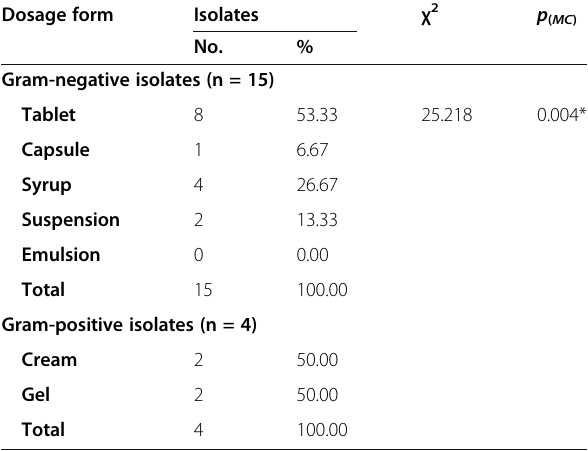
Table 4 Distribution of recovered microbial contaminants from different tested dosage